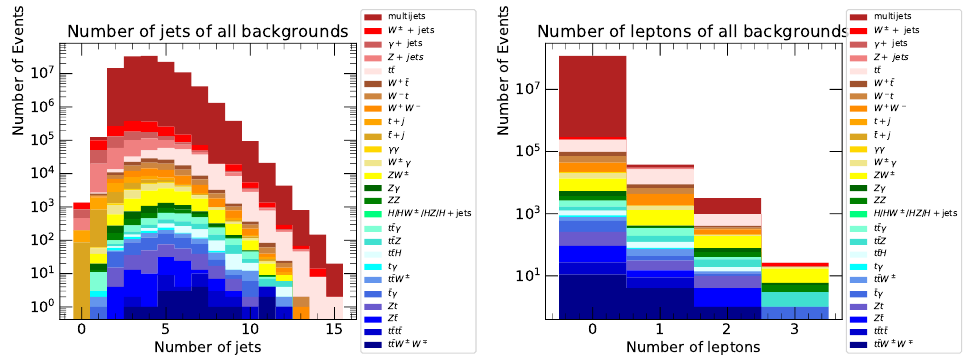
Figure 6: Number of jets (left) and leptons (right).